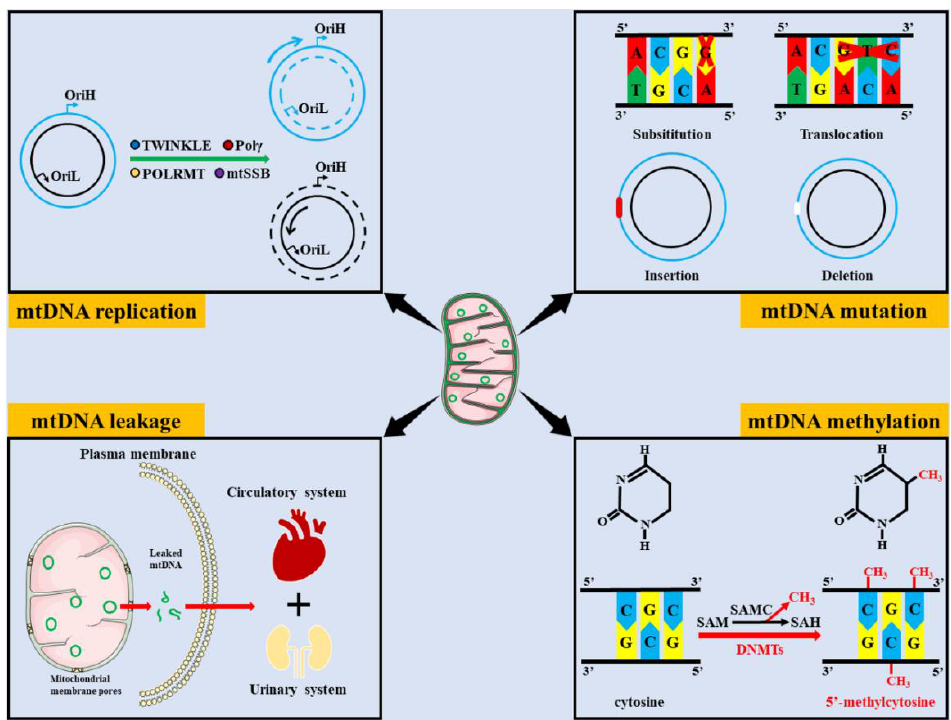
Figure 1. Common types of mtDNA damage. mtDNA damage includes impaired mtDNA replication, mtDNA mutations, mtDNA leakage and mtDNA methylation. mtDNA replication operates in a semi-conserved manner and contains multiple enzymes, such as TWINKLE, Pol γ , POLRMT, and mtSSB, which may hinder mtDNA replication when they are disrupted. The common types of mtDNA mutation includes substitution, translocation, insertion, and deletion. Leaked mtDNA can be transferred to peripheral plasma and urine via the circulatory and urinary systems, respectively. Under the action of DNMTs, the methyl donor compounds derived from SAM are transferred to CpG islands to form 5′ -methylcytosine. (OriH, the origin of heavy strand replication; OriL, the origin of light strand replication; Pol γ, polymerase gamma; POLRMT, mitochondrial RNA polymerase; mtSSB, mitochondrial single-strand binding protein; SAM, S-adenosyl-L-methionine; SAH, S-adenosyl-L- homocysteine; SAMC, S-adenosylmethionine carrier; DNMTs, and DNA